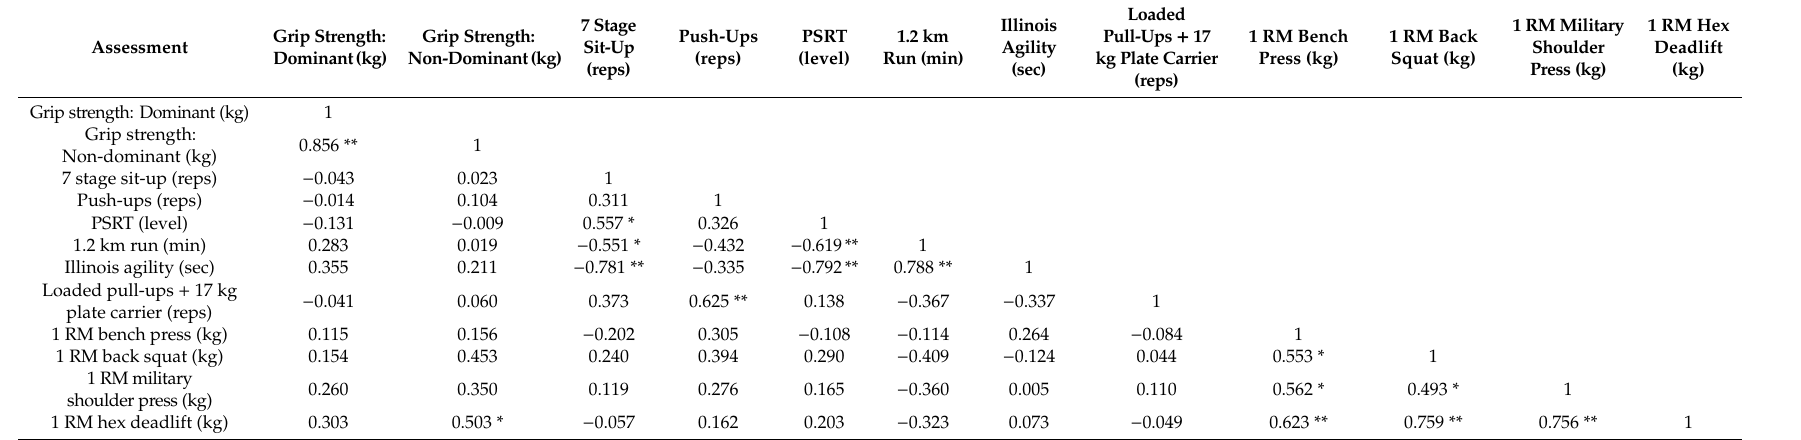
Table A1. Correlations between fitness